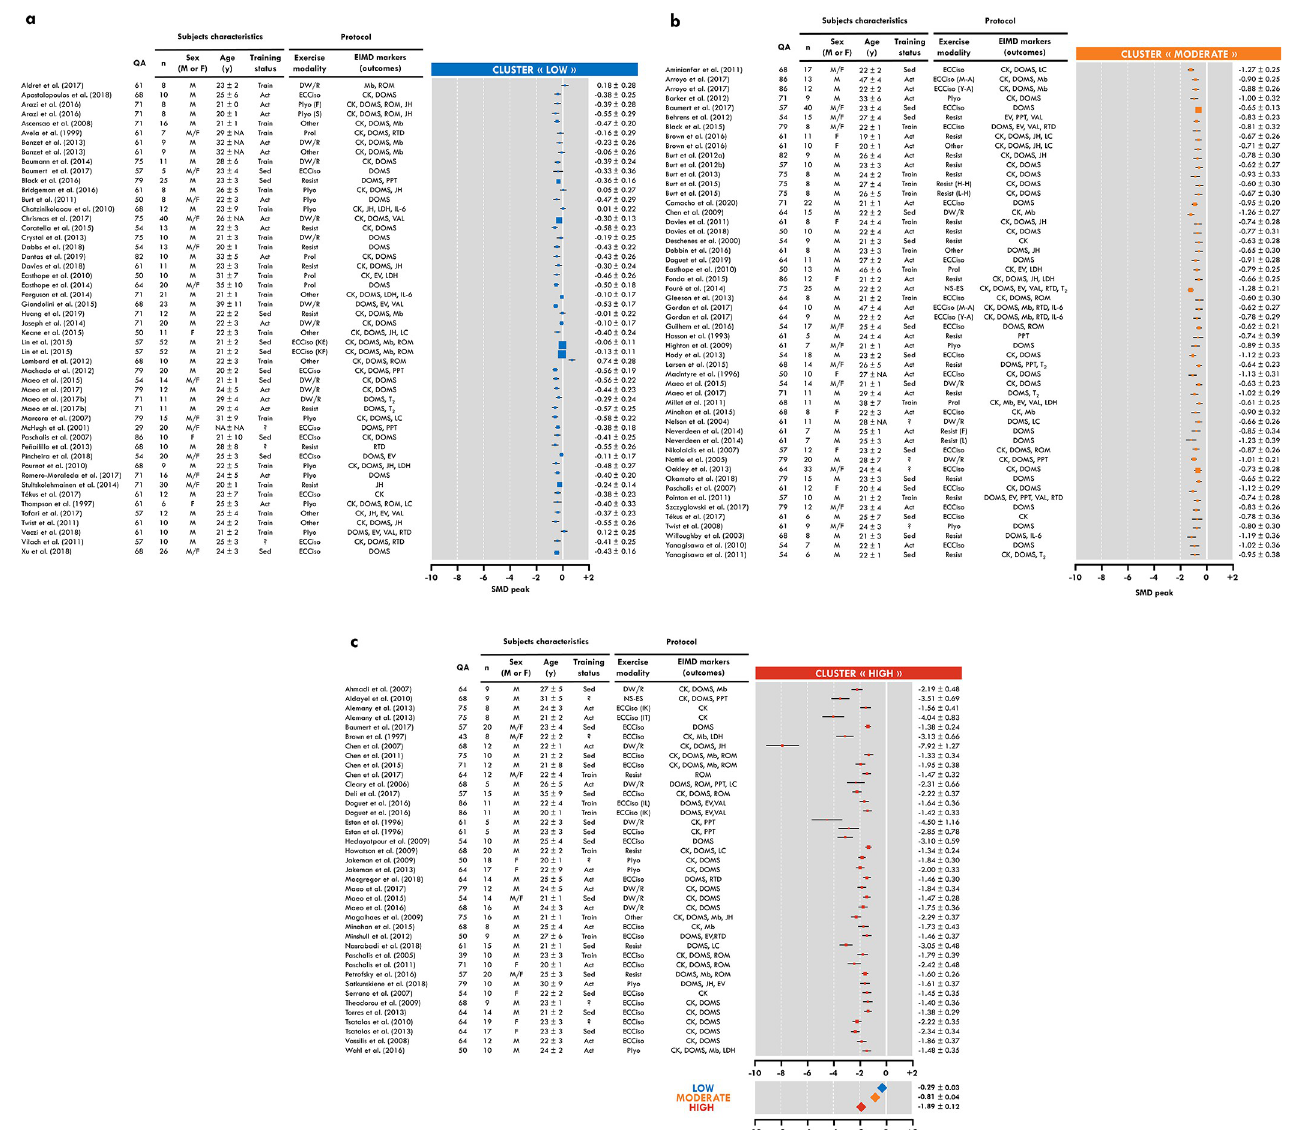
Fig 2. Summary of included experimental groups with forest plot for low (a), moderate (b) and high (c) clusters. QA: Quality assessment; EIMD: exercise- induced muscle damage; Sed: Sedentary; Act: Active; Train: trained;?: unknown; ECCiso: eccentric contractions using an isokinetic ergometer; Plyo: Plyometric exercise; Resist: Eccentric/resistance exercises; DW/R: downhill walking/running; Prol: prolonged aerobic exercise; NM-ES: Neuromuscular electrostimulation; CK: creatine kinase; DOMS: delayed-onset muscle damage; Mb: myoglobin; ROM: range of motion; JH: jump height; EV: evoked response; PPT: pain pressure threshold; VAL: voluntary activation level; LDH: lactate dehydrogenase; RTD: rate of torque development; LC: limb circumference; IL-6: iterleukin-6; T 2 : transverse relaxation time. “n” represents the number of participants of the experimental group. Data are displayed as standard mean difference (SMD) ± standard